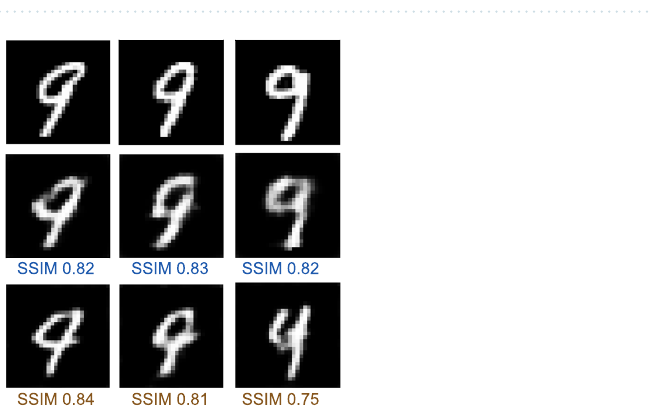
Figure 5. Performance of a VGG-type network for MMF image reconstruction. ( a ) Schematic of the VGG-type network, which consists of two convolutional layers, a dense hidden layer with N h nodes, and a dense output layer. ( b ) Training curves for SHL-DNN and VGG-type networks: the baseline SHL-DNN corresponding to Fig. 1c, with 4096 hidden layer nodes (blue), and VGG-type networks with N h = 4096 (dark green), N h = 784 nodes (light green), and N h = 128 (yellow).